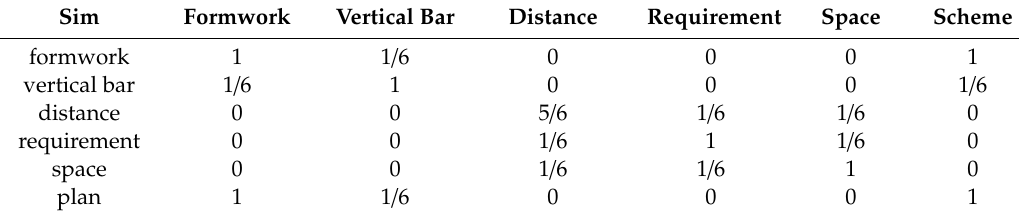
Table 7. Similarity of nouns between N 0 and N 1